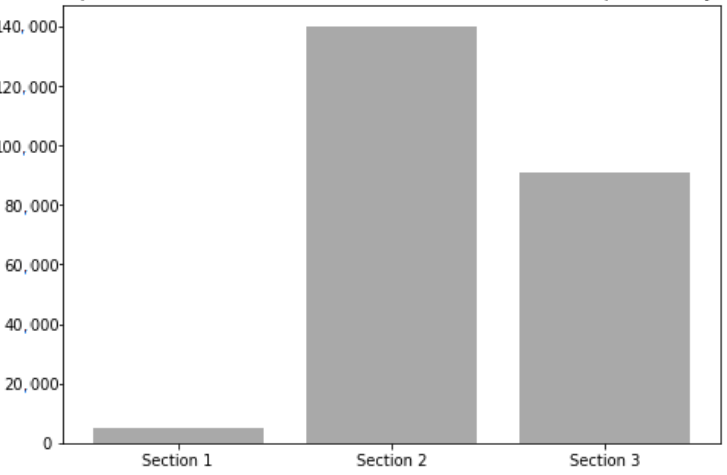
Figure 10. Comparison: Number of Devices in the 3 different areas in Parque das Nações .